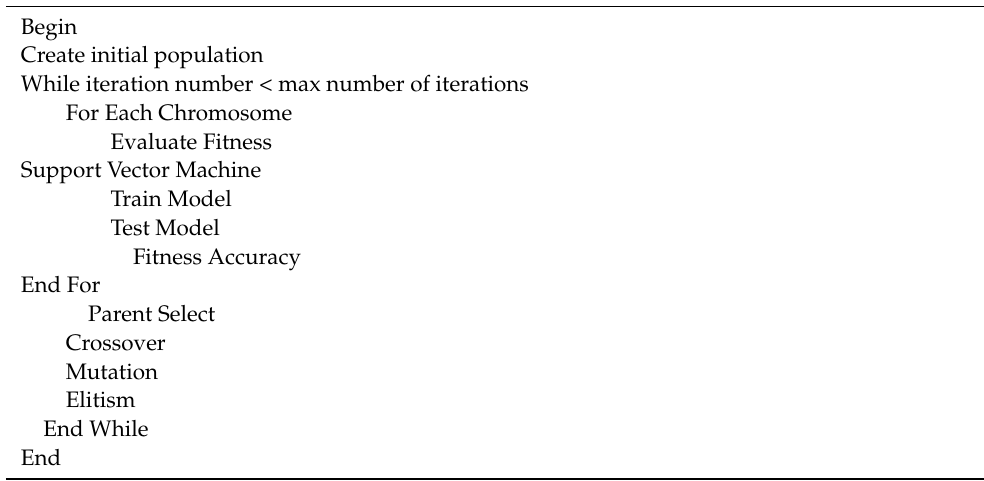
Algorithm 2. The GA-SVM pseudocode.